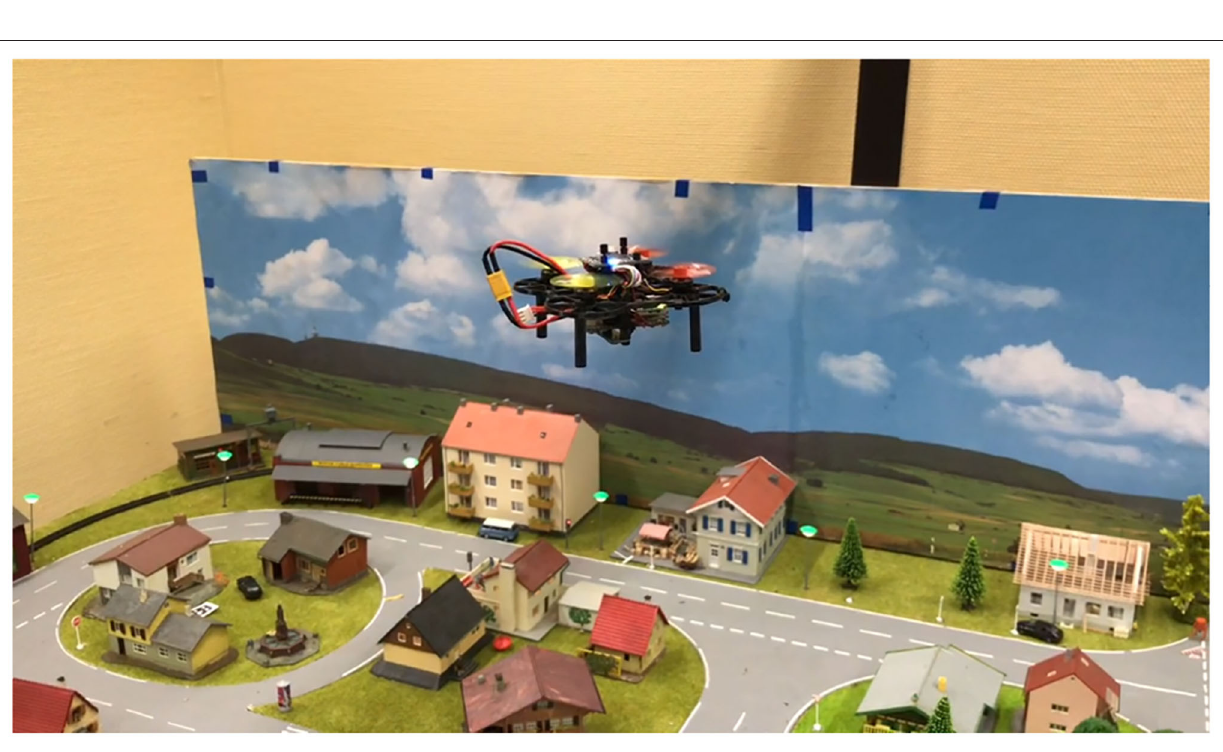
FIGURE 4 | The micro air vehicle is flying over our small test